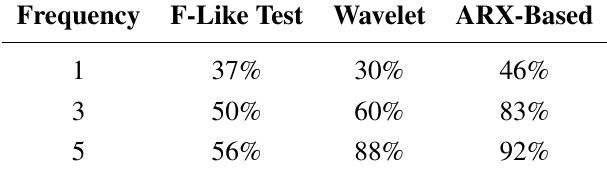
Table 2. Success rate of steady-state identification (SSI) methods for different frequencies for the HX4